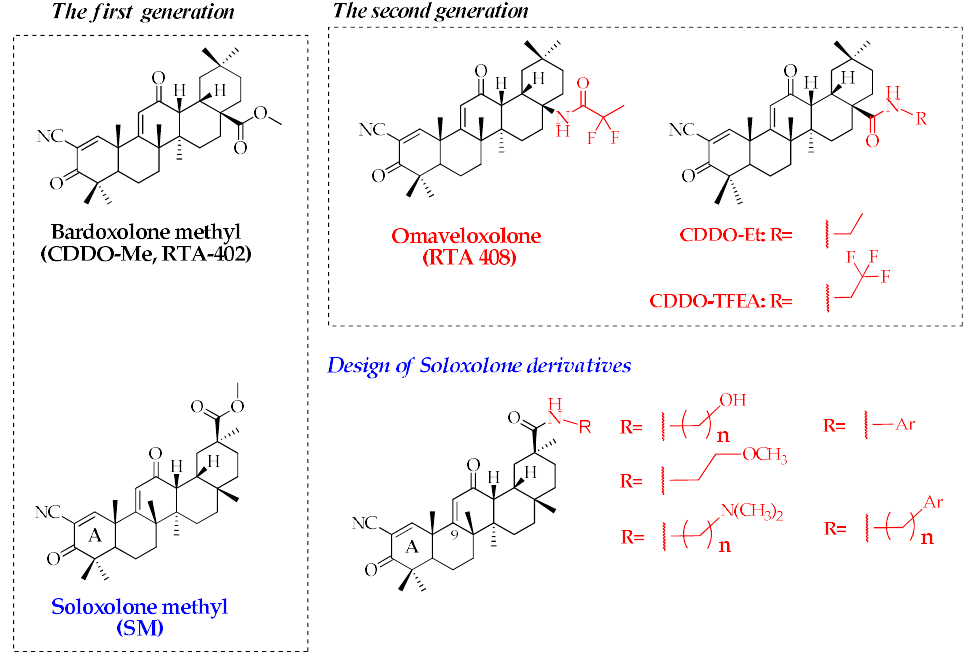
Figure 1. Chemical structures of the first- and second-generation members of semi-synthetic triterpenoids bearing the cyano enone moiety.